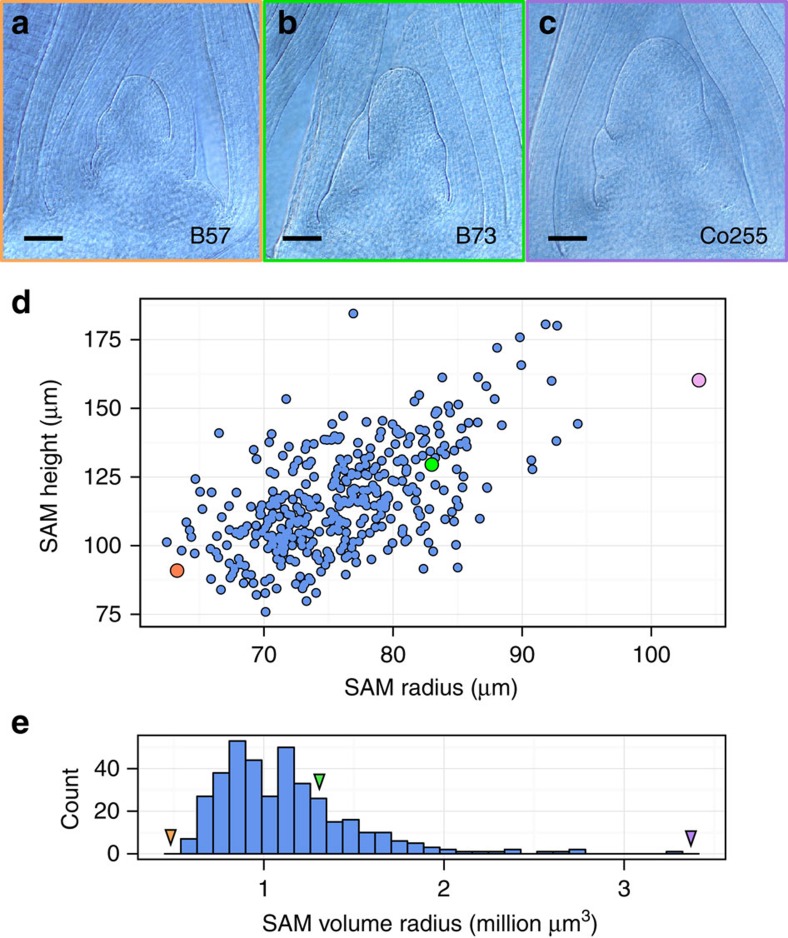
Extreme variation in maize SAM morphology.(a–c) Examples of small (a), intermediate (b) and large (c) SAM lines. (d) BLUPs calculated for SAM height and radius, (n=4). (e) SAM volume estimated by parabolic model of SAM shape. Points/arrows highlight small, intermediate and large accessions, B57 (orange), B73 (green) and Co255 (purple), respectively. Scale bars, 100 μm.